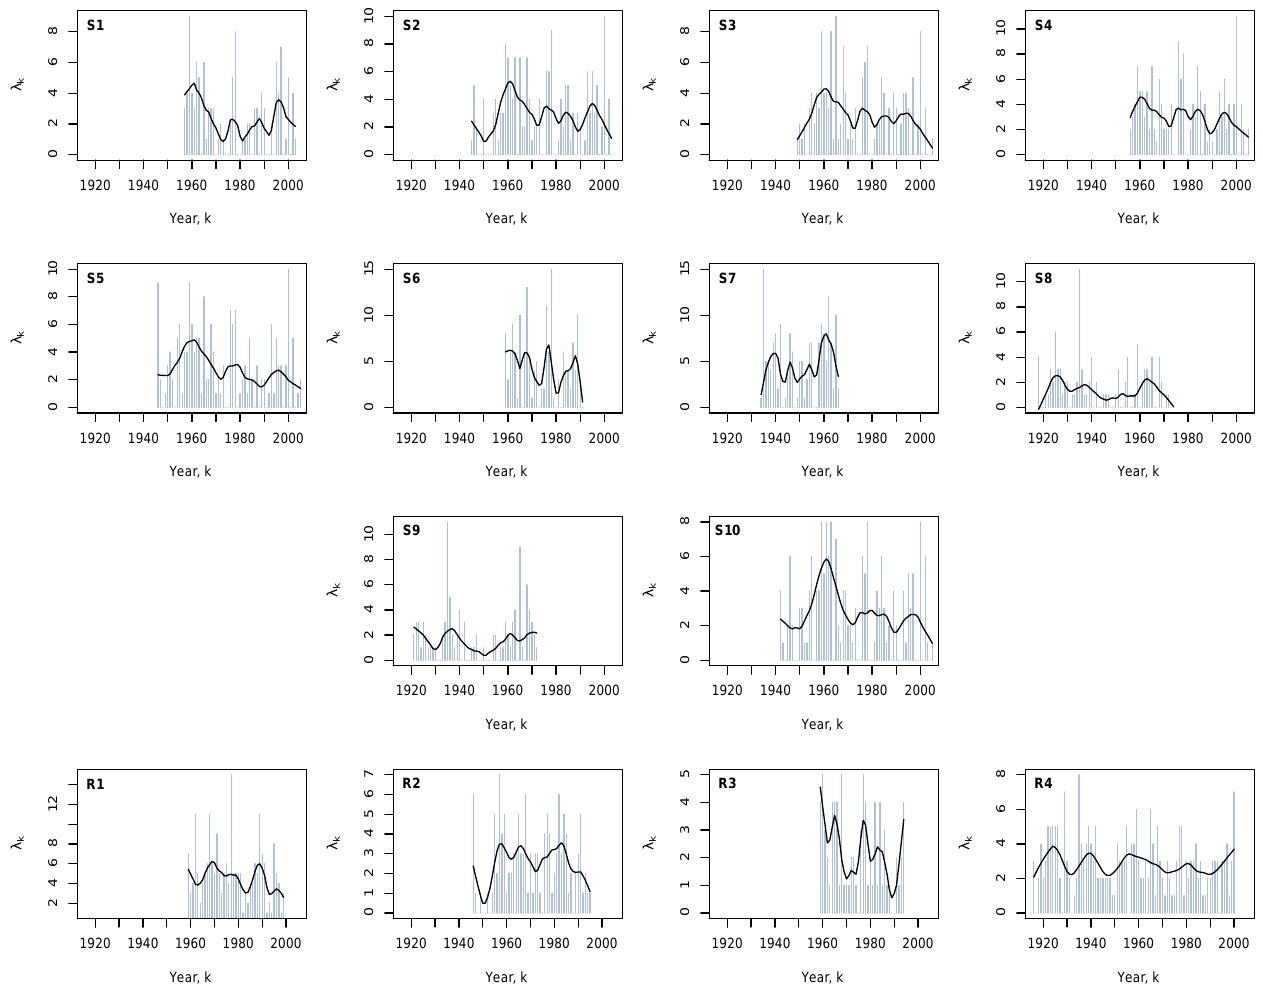
Fig. 6. Number of extremes in year k , λ k (bars). inter-annual variability described by a LOWESS curve fitted to data, with a smoothing parameter f = 0.2 (solid lines).